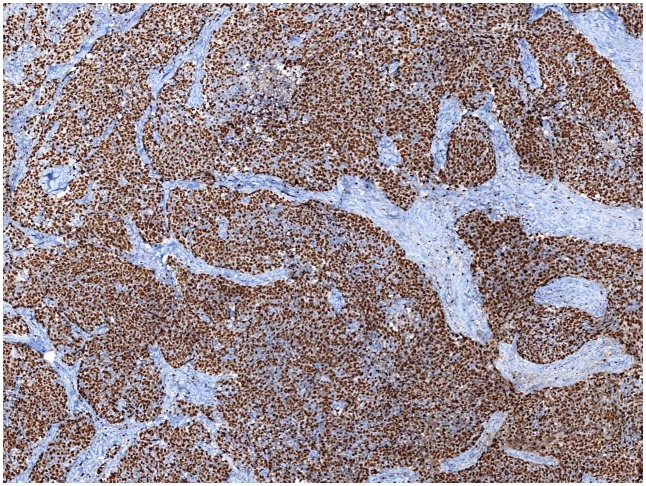
A homogenously stained case of Ki67.With a homogenous diffuse high Ki67 LI across the slide.